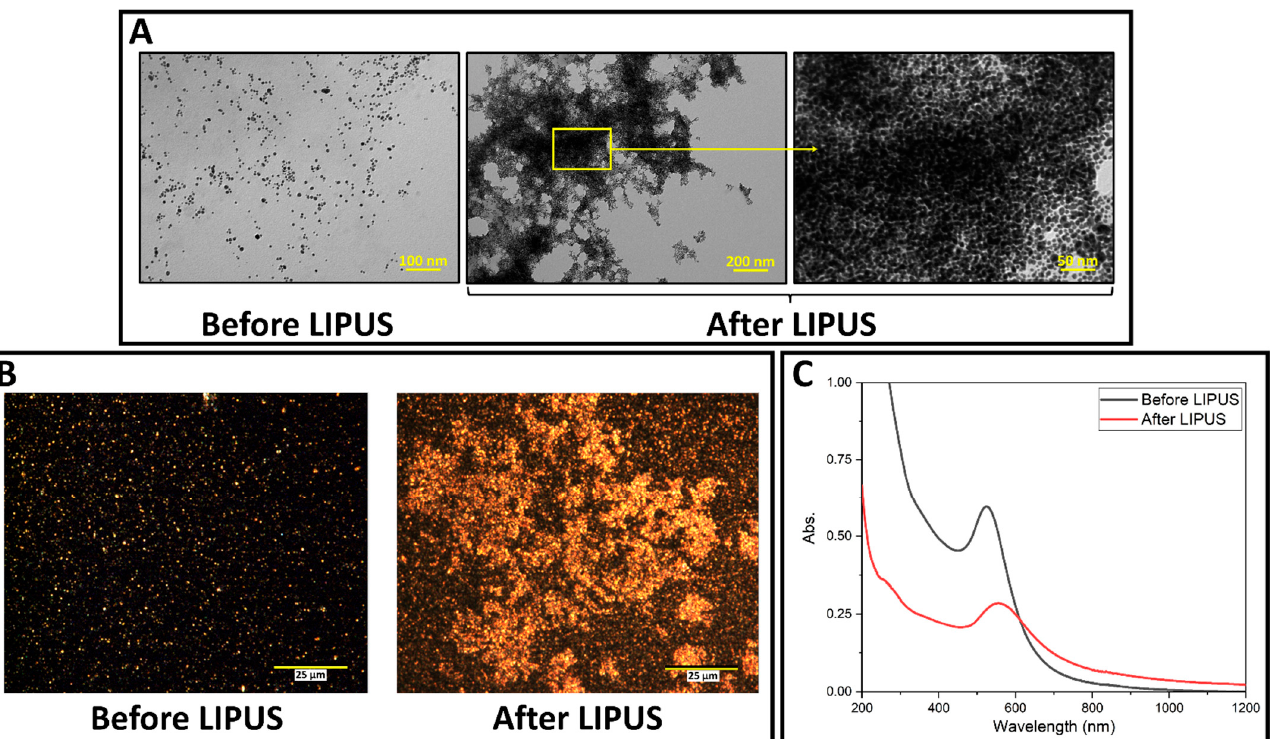
Figure 3. ( A ) TEM images of DOX-loaded GNPs before and after LIPUS exposure in the GNP chamber embedded in ex vivo tissue; ( B ) darkfield microscopy images of DOX-loaded GNPs in the GNP chamber before and after LIPUS exposure in ex vivo tissue. ( C ) UV-vis spectra of DOX-loaded GNPs before and after LIPUS treatment.